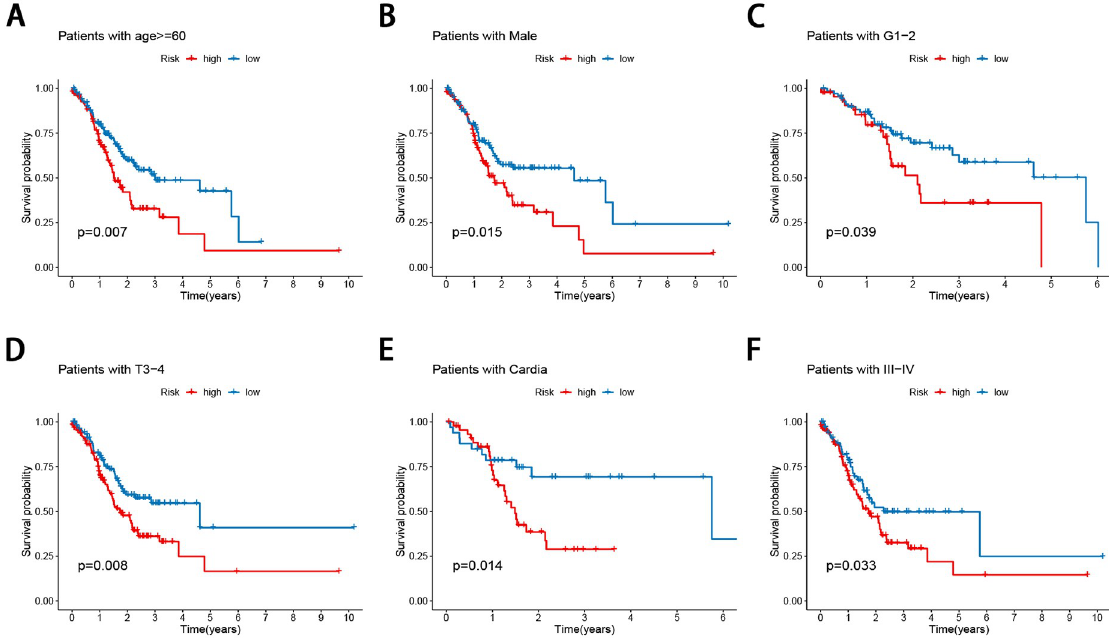
Fig 5. Stratification analyses by clinicopathological parameters. The survival difference between high- and low-risk group stratified by (A) age (B) gender (C) grade (D) T (E) tumor site (F) TNM stage.